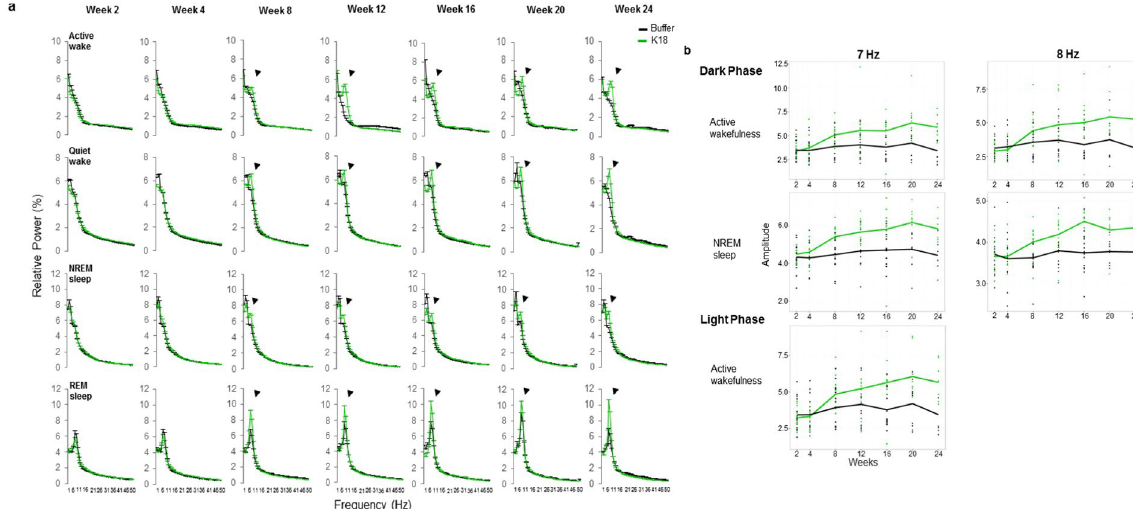
Figure 1. ( a ) Cortical (epidural) mean relative EEG power spectra during waking, NREM sleep and REM sleep in buffer controls (black, n = 11, 4 animals were excluded due to mislocation of the injection and electrode sites or signal artefacts) and K18 (green, n = 15) conditions. Note the characteristic increases in relative theta amplitude after the administration of K18, which is clearly evident in all vigilance states starting from 8 weeks post-treatment onwards. Data are presented as mean values ± SEM for buffer (black) and K18 (green) conditions. (b) longitudinal changes in the amplitude at frequency bins centered at 7 and 8 Hz with the time during active waking and NREM sleep as observed in K18 treated animals. ANOVA with post hoc Hochberger’s and Dunnett’s